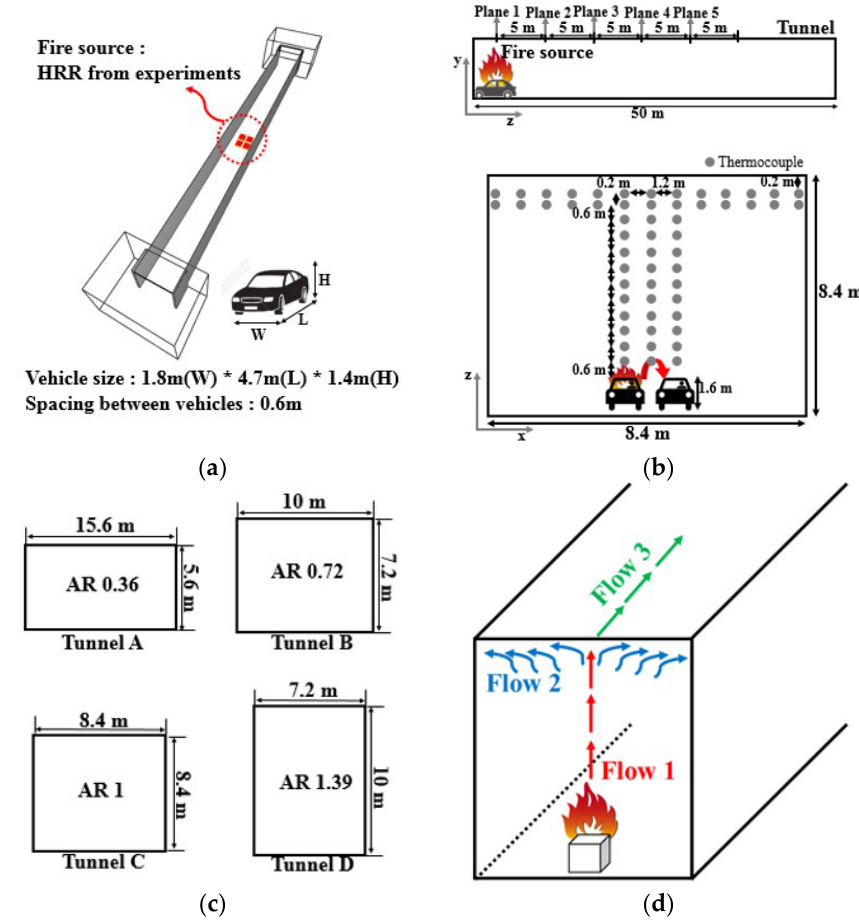
Figure 3. Numerical study: ( a ) computational domain for tunnel, ( b ) location of thermocouples and analysis planes, ( c ) cross-section of tunnel for varying aspect ratio and ( d ) main flow in case of tunnel fire.